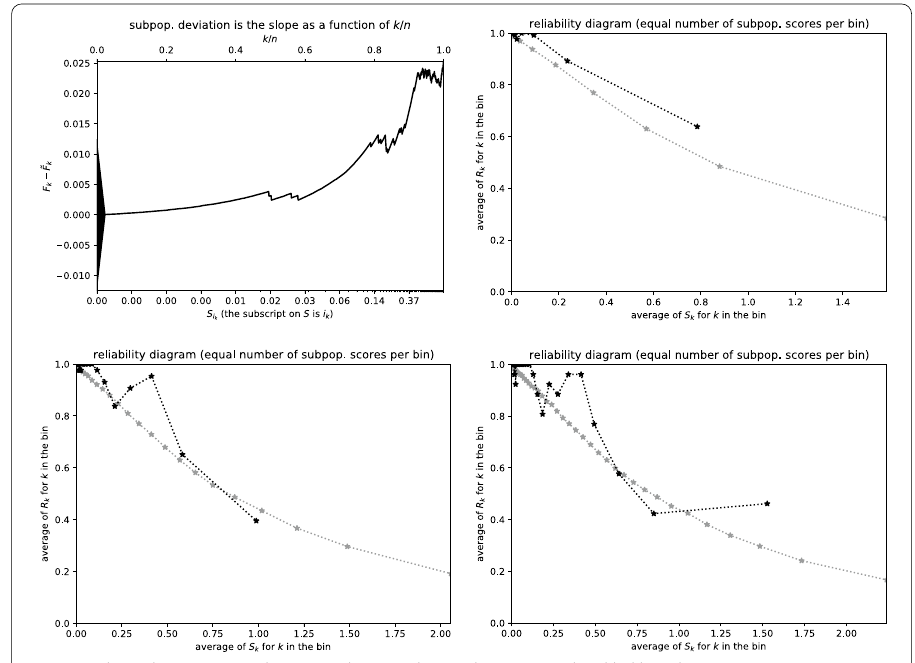
Fig. 15 Cheetah (Acinonyx jubatus), with scores being the negative log-likelihoods; n = 1300; Kuiper’s statistic is 0.02520 /σ = 4.043 , Kolmogorov’s and Smirnov’s is 0.02520 /σ = 4.043 . Only the reliability diagram with 50 bins detects the high deviation for negative log-likelihoods greater than 1.25; the diagrams with only 10 or 30 bins give no indication of the substantial deviation. 30 bins or less are clearly insufficient to resolve the significant deviation, but that is clear only upon comparison with the cumulative plot or with diagrams having many bins. The scalar summary statistics indicate statistically significant deviation of the subpopulation from the full population, in accord with the plot of cumulative